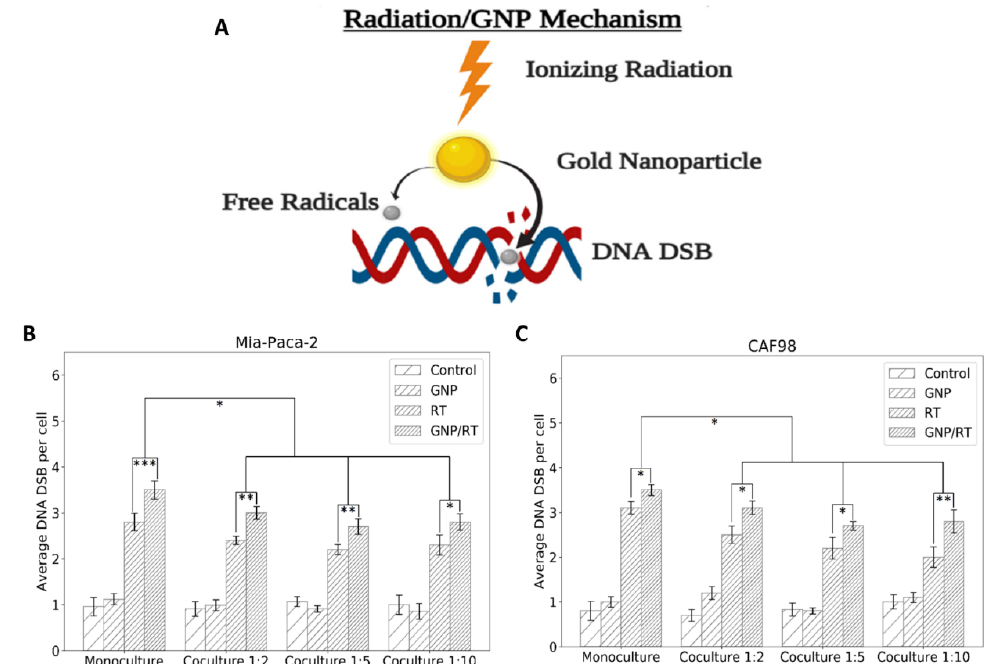
Figure 5. DNA DSB damage in MIA PaCa-2 and in CAFs. ( A ) GNP-mediated radiation damage mechanism. ( B ) Average number of DNA DSB damage per cell in MIA PaCa-2in monoculture vs. in co-culture ( n = 3). ( C ) Average number of DNA DSB damage per cell in CAFs in monoculture vs. in co-culture ( n = 3). * indicates p < 0.05, ** indicates p < 0.01, *** indicates p < 0.001.